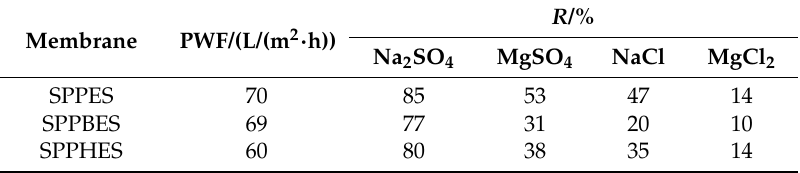
Table 5. Separation performance of sulfonated poly(aryl ether sulfone) composite membrane.